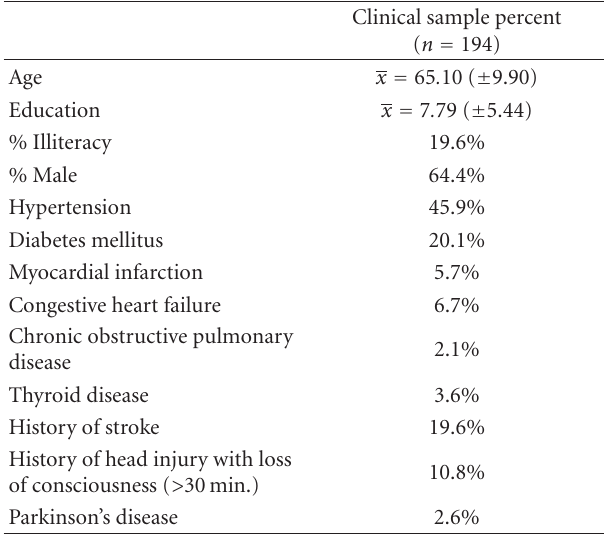
Table 1: Description of demographic features of the clinical group.